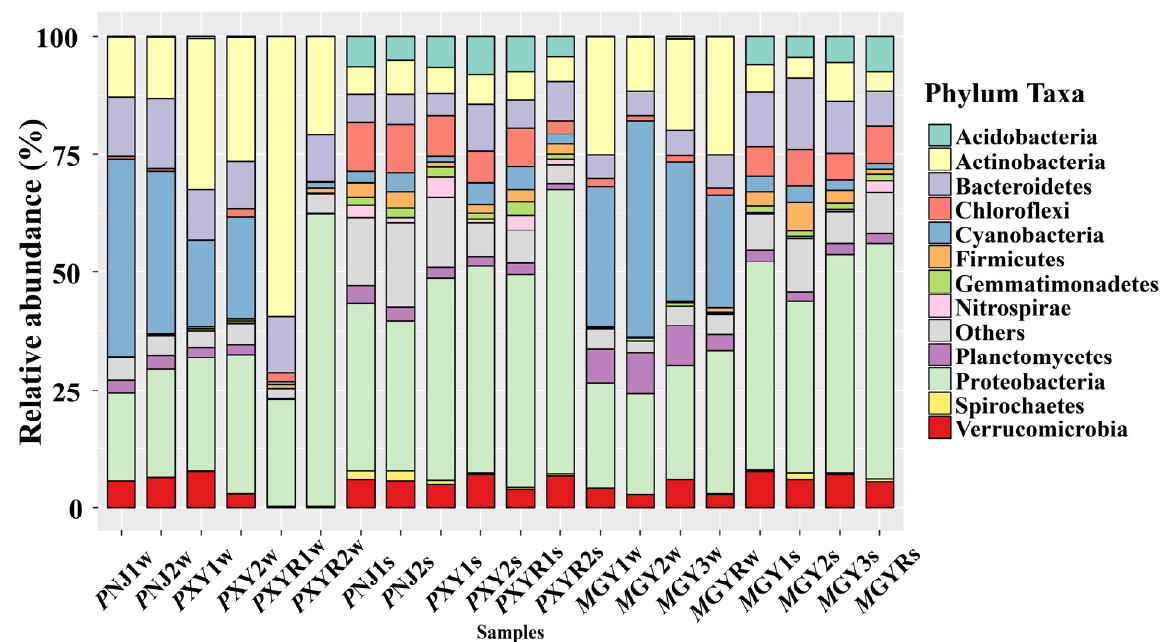
Figure 2. Bacterial community structures of all environmental samples collected from the P. clarkii and M. rosenbergii aquaculture environments at the phylum level.